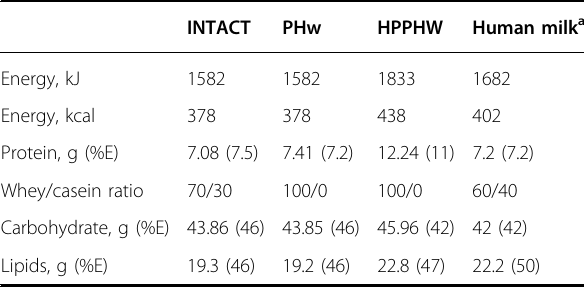
Table 1 Energy and macronutrient composition of infant formulas and human milk per 600 ml as